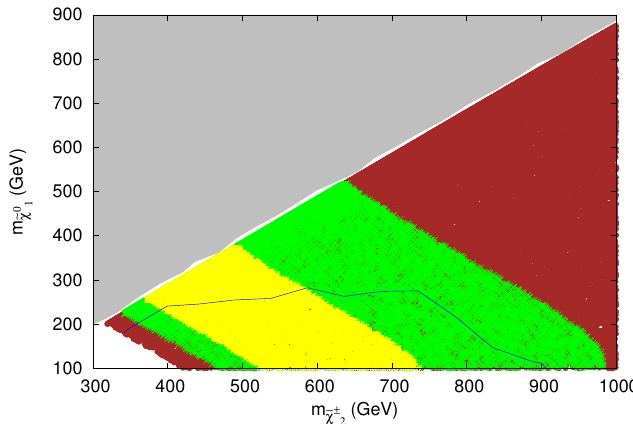
(cid:0) m plane in the CLHHS ( e B (cid:0) f W ) model. The blue (cid:6) e (cid:31) 0 1 e (cid:31) 2